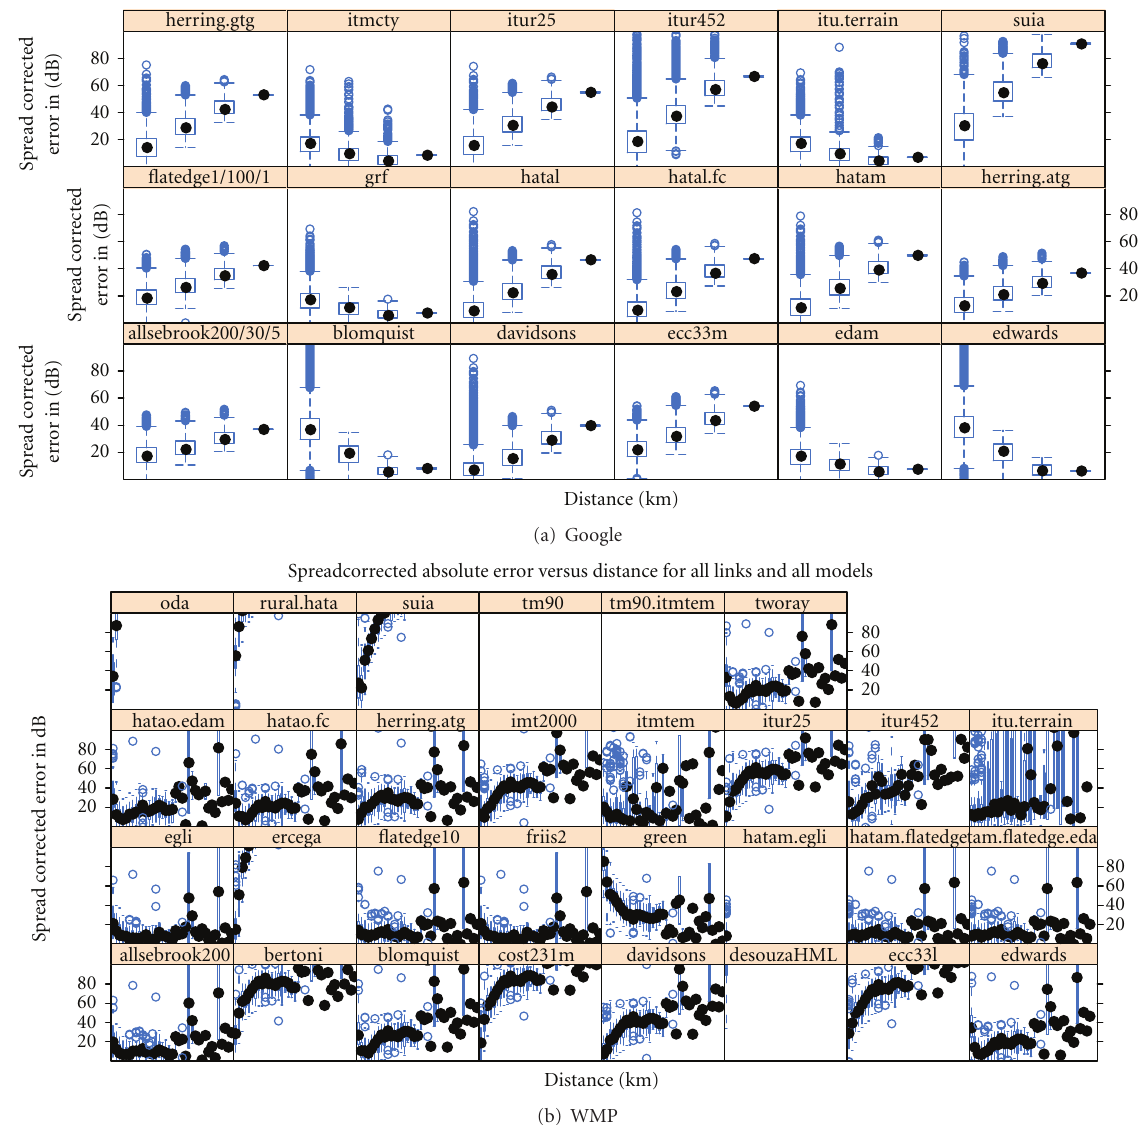
Figure 11: Correlation between model accuracy and link distance for each data set. Distance is bucketed by